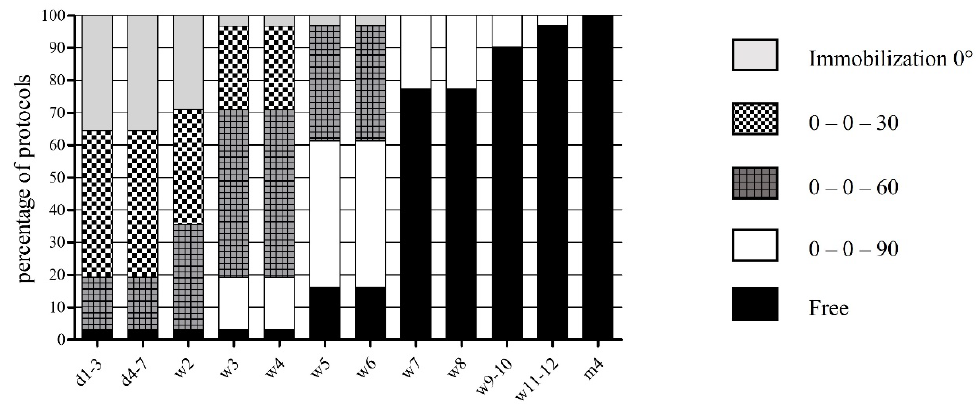
Figure 2. Early rehabilitation phase after PCL-R concerning range of motion (ROM), expressed in percentage of protocols (%). d: day, w: week.